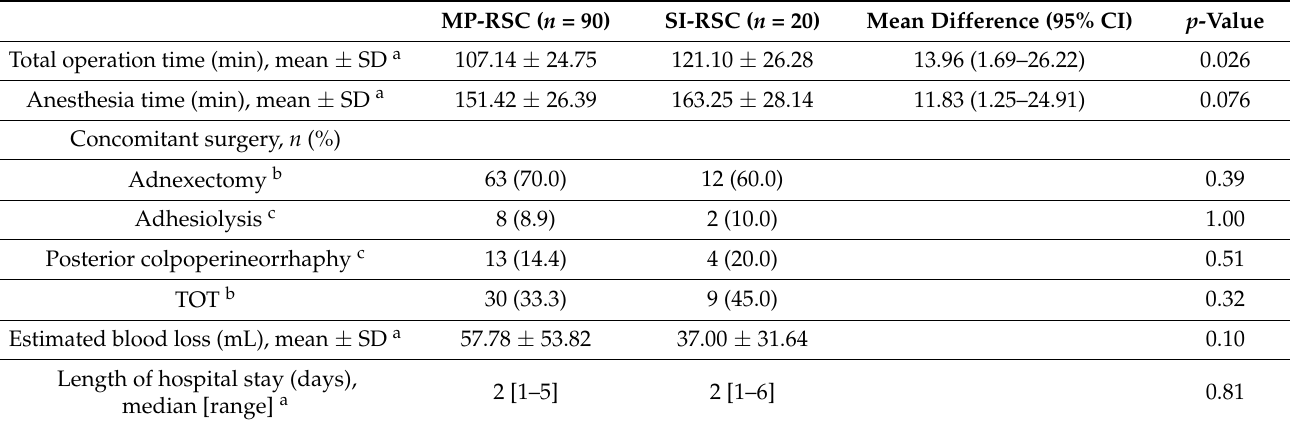
Table 3. Surgical and perioperative data excluding vault prolapse